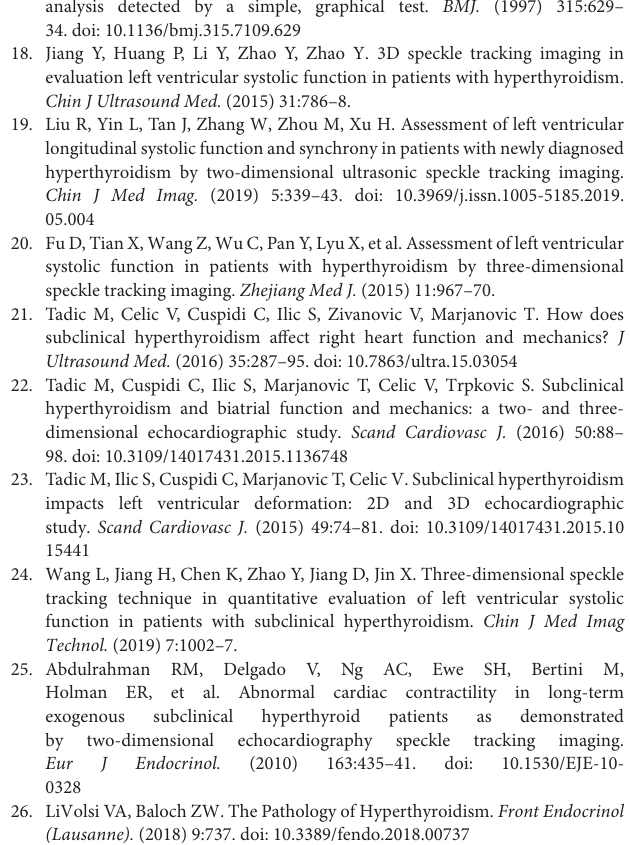
(part B). Supplementary Table 8 | Publication bias of summarized